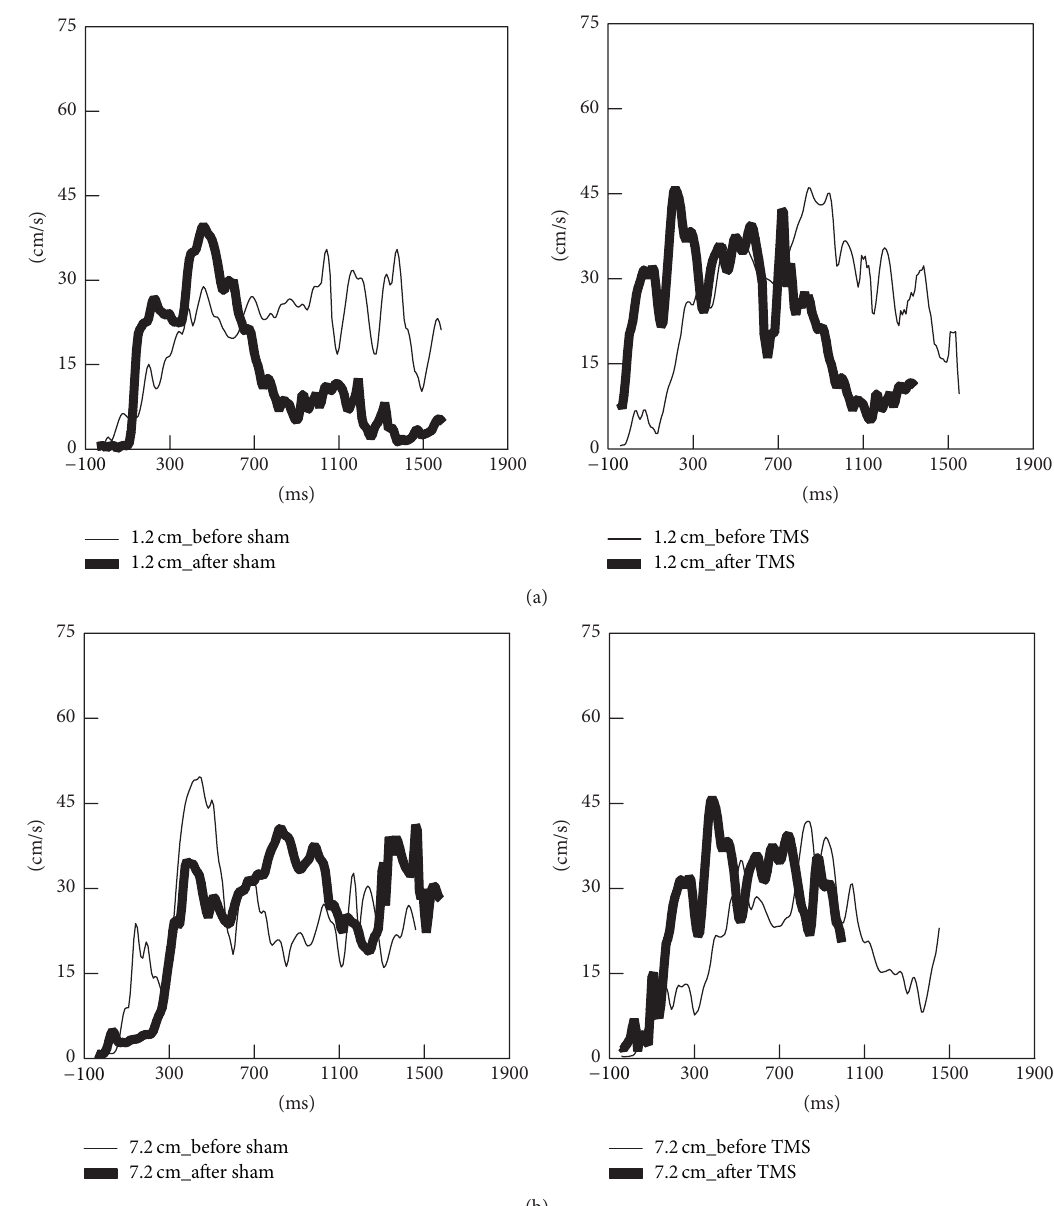
Figure 2: Representative data for transport velocity during reach-to-grasp actions to the small object (a) and the large object (b) following sham (left) and real rTMS conditions (right). The thin trajectories represent baseline performance; the thick trajectories represent performance after each TMS